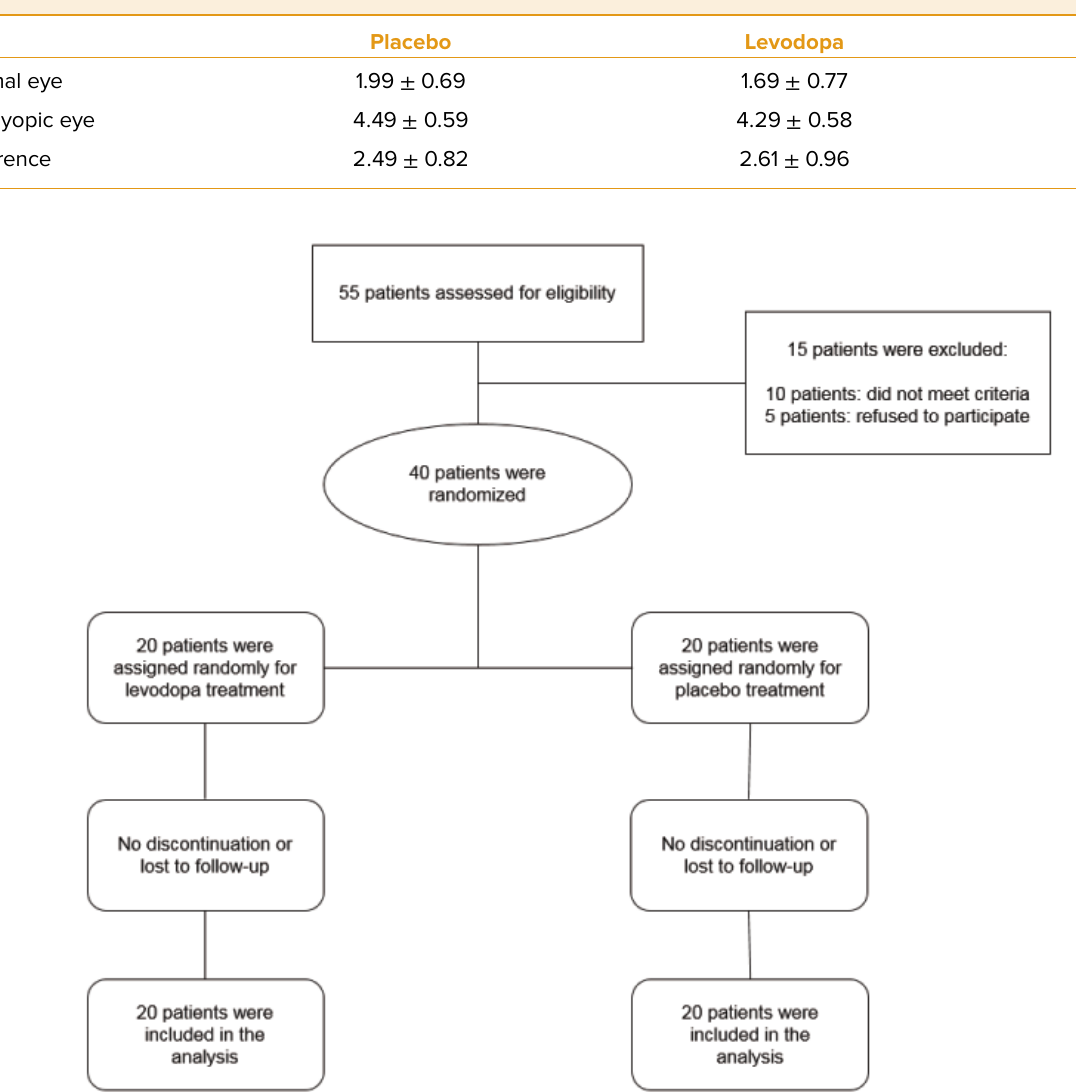
Figure 1. Flow diagram outlining the enrollment of the amblyopic children into the